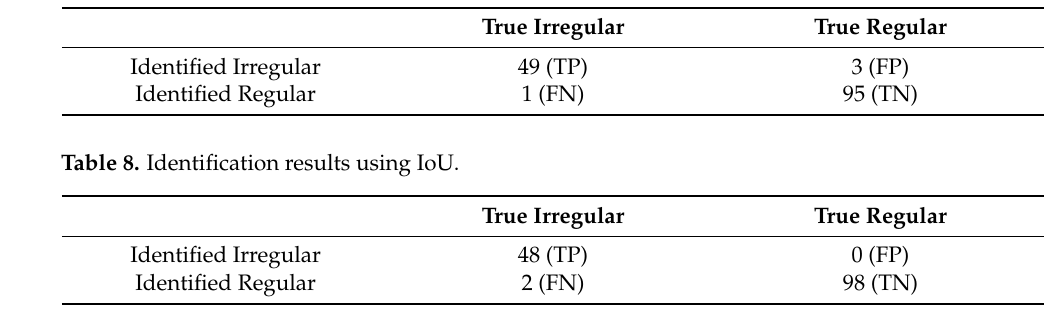
Table 7. Identification results using Hausdorff distance.